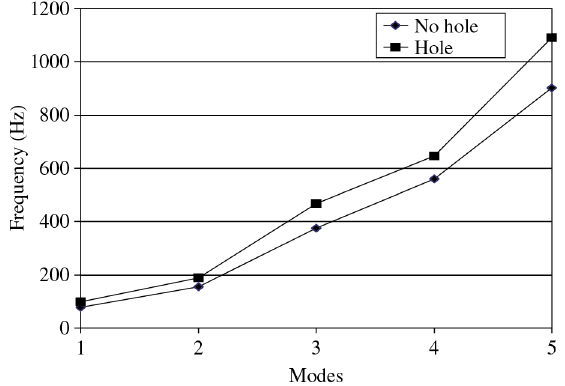
Figure 7: Frequency